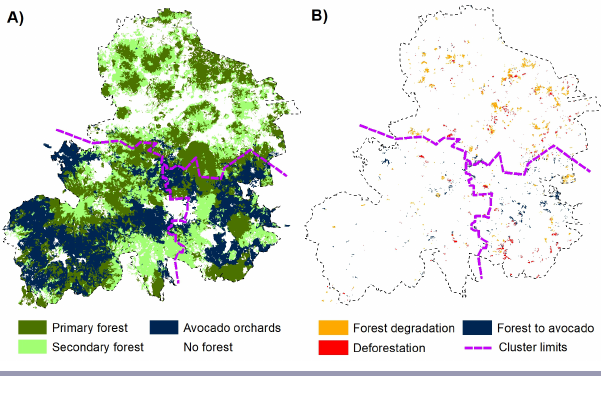
Fig. 3 . Maps representing: (A) the initial land-cover/use (2004), (B) forest-cover changes (2004-2014). Data obtained from the land-cover/use maps elaborated by Mas et. al (2017).